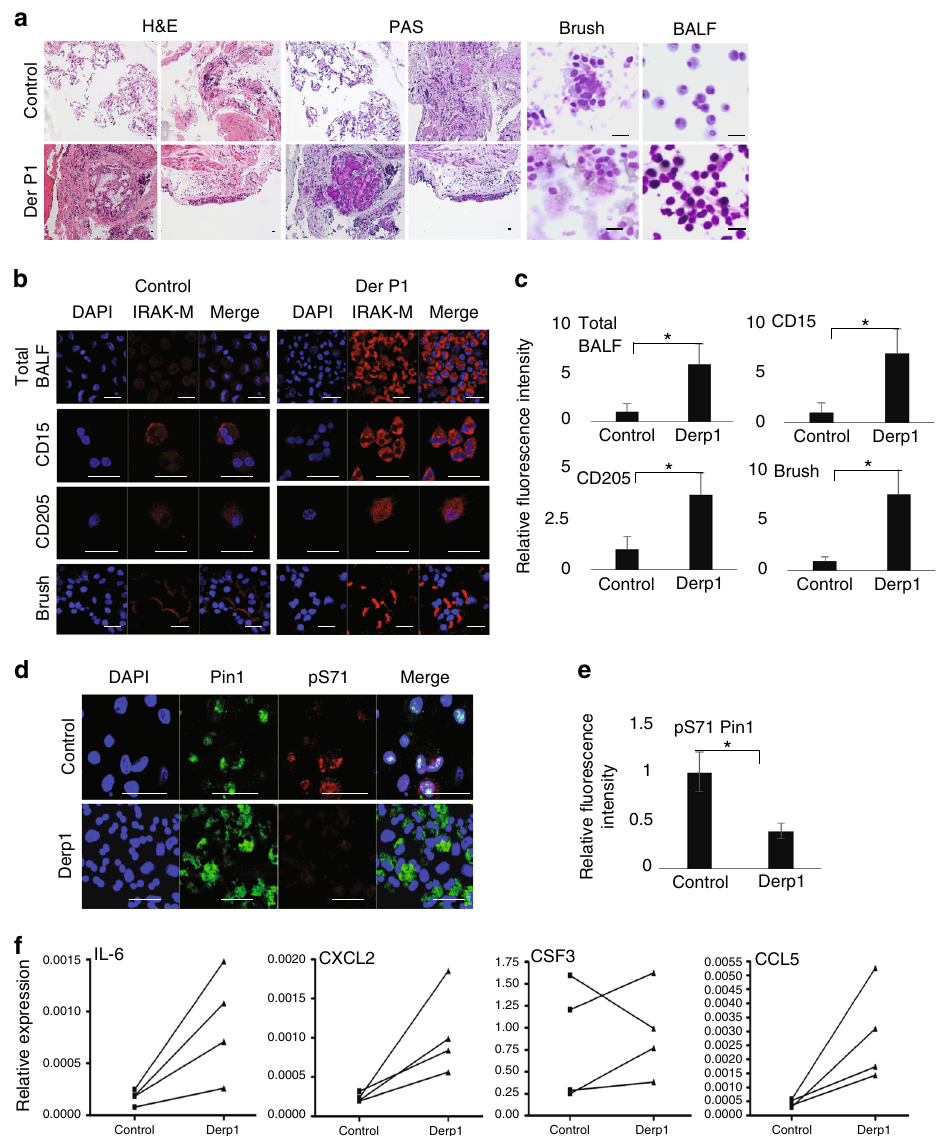
Fig. 7 IRAK-M expression is elevated in asthmatic human samples after Derp1 segmental allergic challenge. a Representative H&E staining and PAS staining of lung biopsies before and after Derp1 segmental challenge, as well as BALF and brush cytospins before and after treatment stained with Giemsa ( n = 4). b Cytospin slides of brushing, total BALF cells, BALF CD15 + and CD205 + cells samples were immune stained for IRAK-M. c Quanti fi cation of IRAK-M expression in total BALF cells, BALF CD15 + and CD205 + cells samples as in b using Velocity program. d Total BALF cells were immune stained for PIN1 and pS71PIN1 and quanti fi ed using Velocity program e . f RNA was extracted from BALF cellular contents and analyzed for the relative expression of Il6 , Csf3 , Cxcl2 and Ccl5 by qRT-PCR. The data were analyzed by a Student ’ s two-tailed t test and the values are reported as mean ± standard errors of the means (SEM). *- statistical signi fi cance ( P < 0.05), **- signi fi cance ( P < 0.01). Scale bar = 50 µ bound IRAK-M DD subunits in the Myddosome, inducing the dissociation of IRAK-M from the Myddosome complex. This (Fig. 8). The precise mechanisms by which IRAK-M stability and nuclear translocation are achieved will require further study. IRAK-M can shuttle to and out of the nucleus 60 . Although we show that IL-33 challenge causes PIN1-dependent nuclear translocation of IRAK-M, the precise role of IRAK-M in the nucleus has not yet been reported. Given the correlation observed here between IRAK-M expression and the upregulation of several genes, it is tempting to speculate that IRAK-M might induce gene expression by an as yet unknown mechanism. Our genome wide expression pro fi ling has identi fi ed four genes ( Il6 , Cxcl2 , Csf3 and